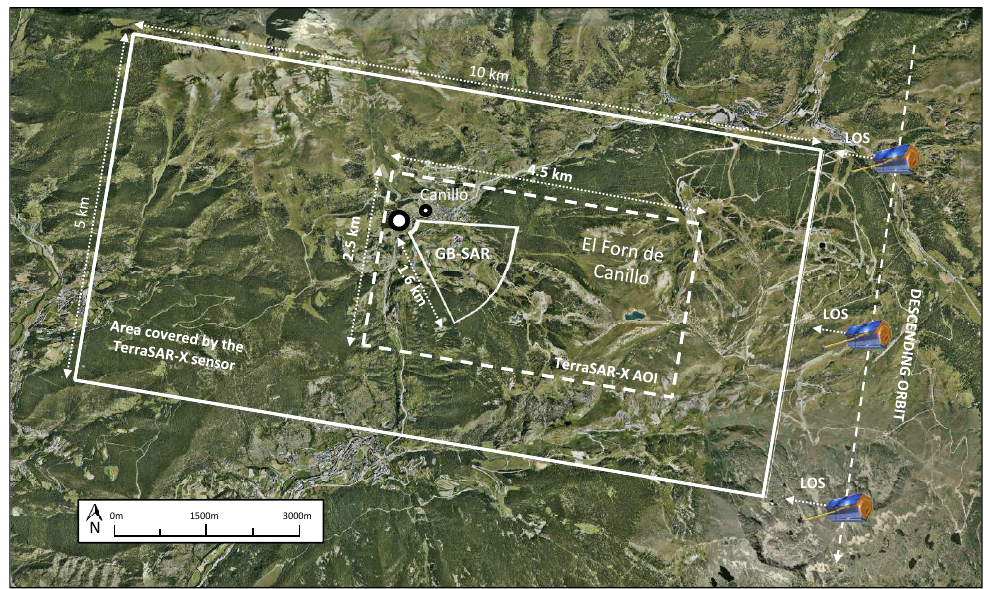
Figure 2. Coverage of the TerraSAR-X and RiskSAR-X sensors over the area of El Forn de Canillo. The solid rectangle indicates the TerraSAR-X coverage: 10 km in range per 5 km in azimuth with a heading of 9 . 8 ◦ with respect to the north. Upper left ( 42 . 5896 ◦ latitude, 1 . 5450 ◦ longitude), upper right ( 42 . 5746 ◦ latitude, 1 . 6649 ◦ longitude), bottom left ( 42 . 5452 ◦ latitude, 1 . 5348 ◦ longitude) and bottom right ( 42 . 5302 ◦ latitude, 1 . 6548 ◦ longitude). The dashed rectangle indicates the area of interest selected for the orbital PSI processing: 4 . 5 km in range per 2 . 5 km in azimuth. The RiskSAR-X location is indicated with the white dot ( 42 . 5653 ◦ latitude, 1 . 5921 ◦ longitude). The area illuminated by the GB-SAR sensor is indicated with the solid line within the dashed rectangle: 500 m in height, 1600 m in range and 1000 m in width, with a heading of 32 ◦ with respect to the north.